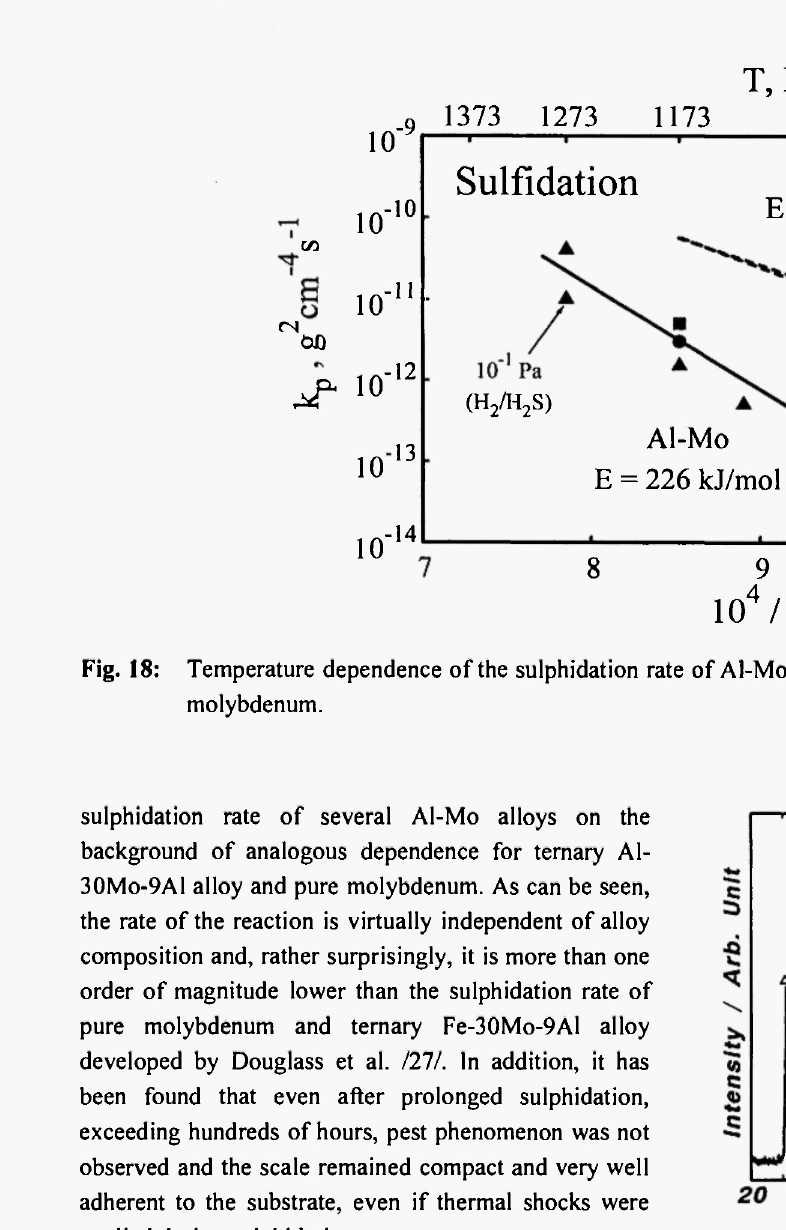
Fig. 19: X-ray diffraction pattern for Al-46Mo alloy sputter deposited on quartz substrate after 36 h sulphidation at 1173